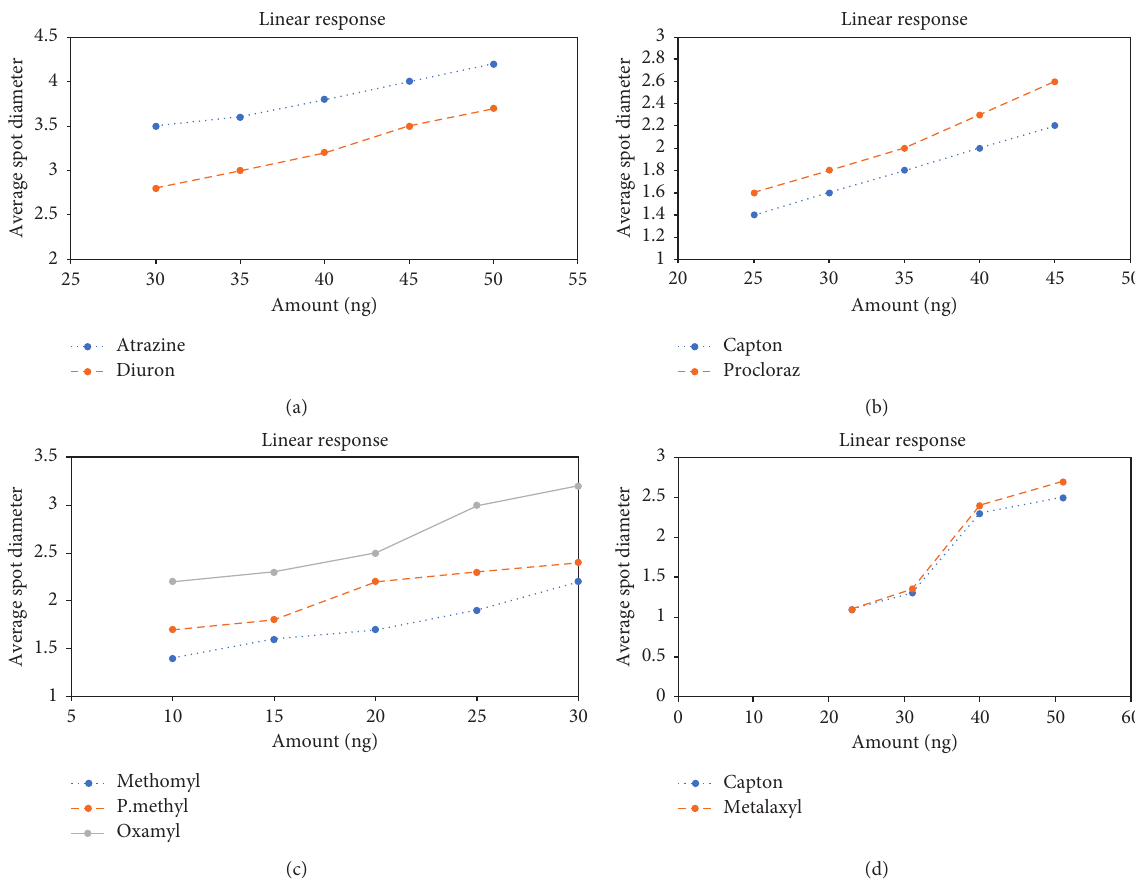
Figure 1: Linear behavior of pesticides during validation of HPTLC used methods. (a) Linear behavior of pesticides in O-tolidine +KI method. (b) Linear behavior of pesticides in fungi spore inhibition method. (c) Linear behavior of pesticides in horse blood serum method. (d) Linear behavior of pesticides in photosynthesis inhibition (hill reaction)